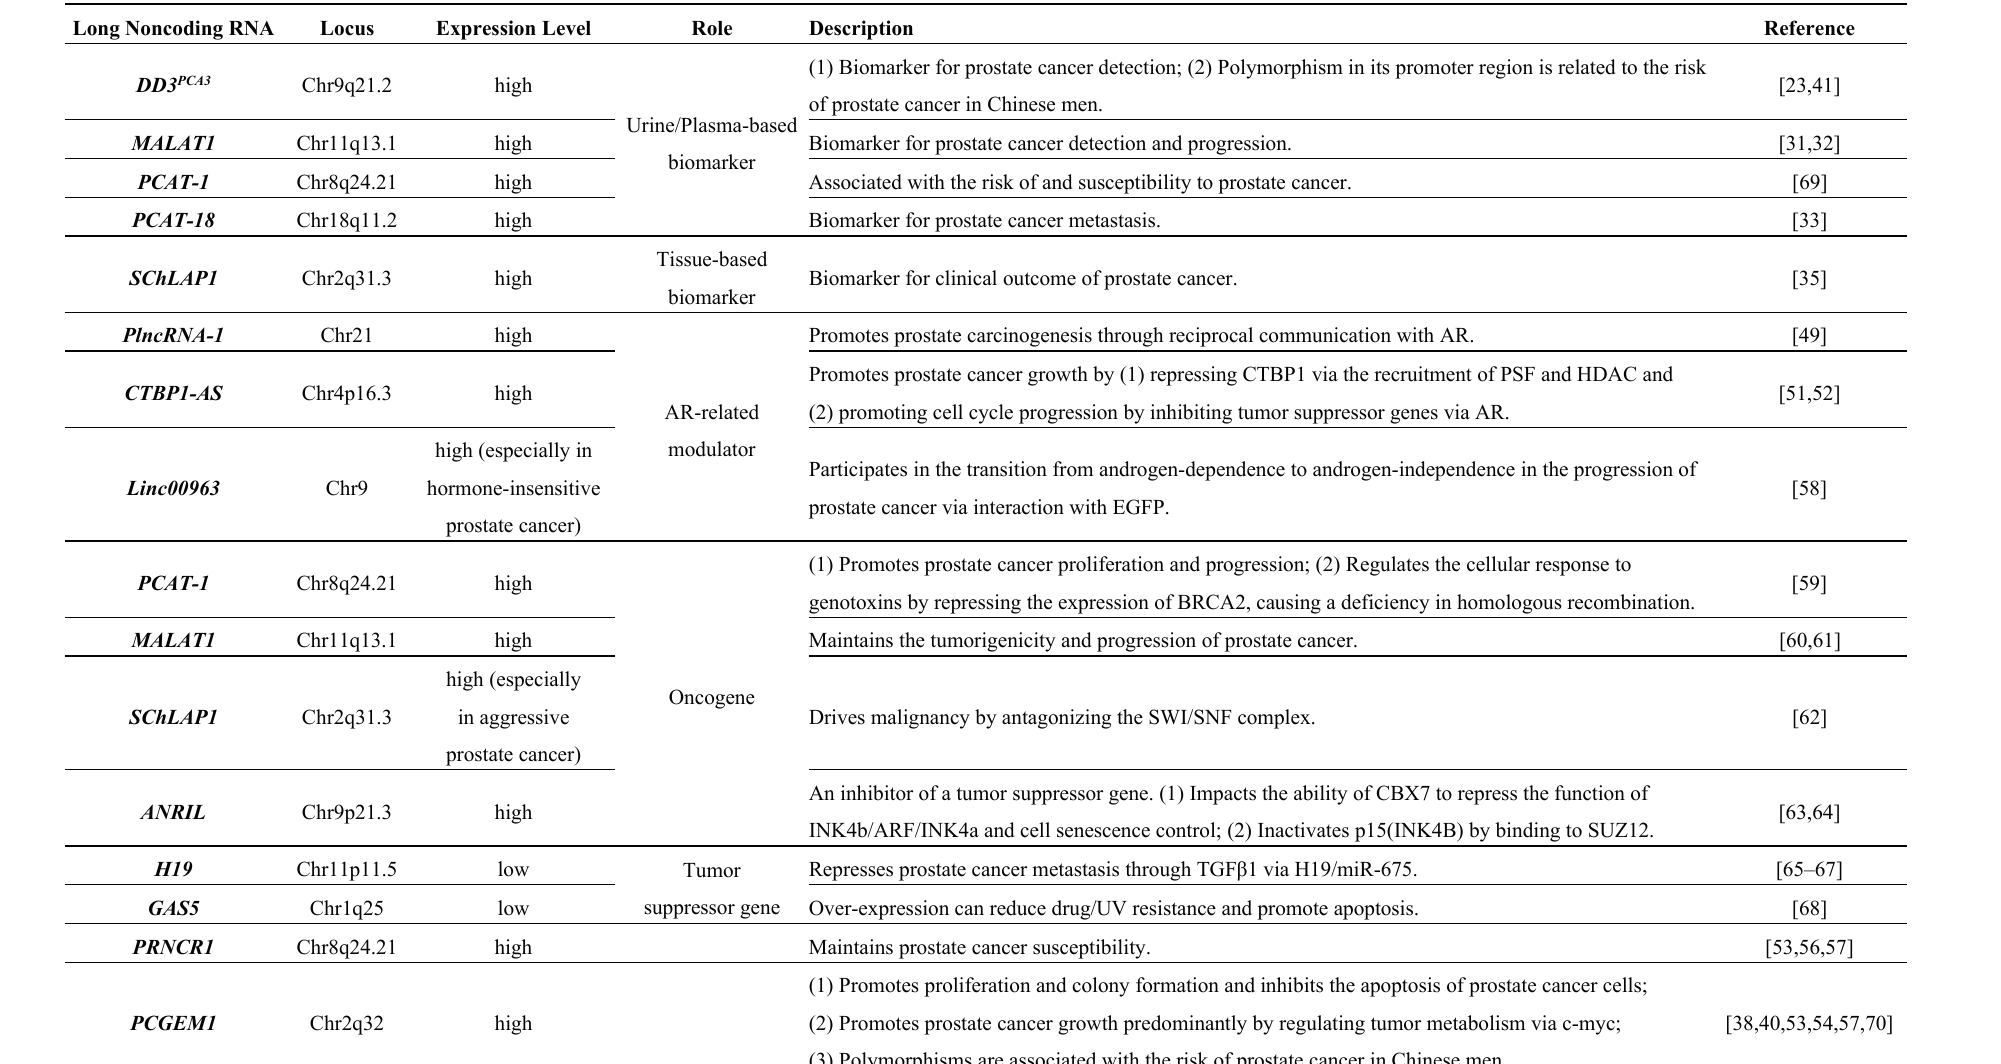
Table 1. Summary of the well-studied prostate cancer-related long noncoding